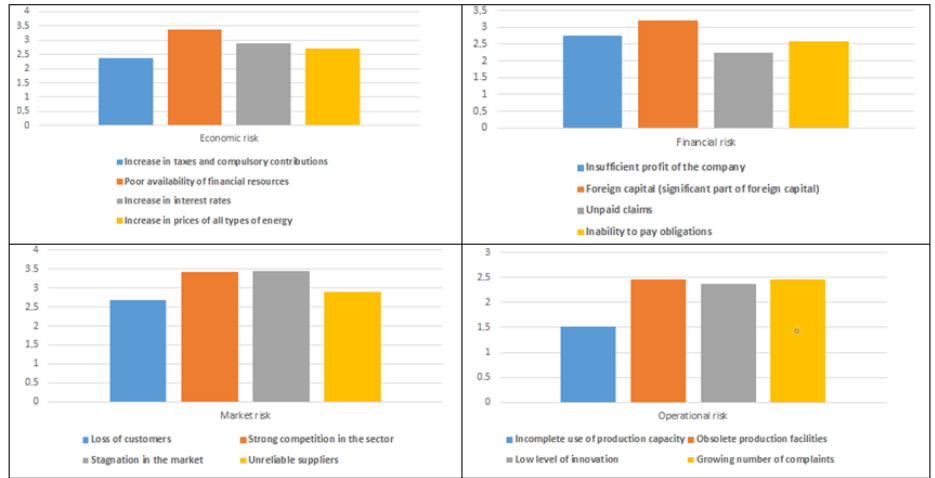
Figure 1. Average rating of the intensity of market, economic, financial, and operational risks in the surveyed enterprises as a result of the pandemic risk.